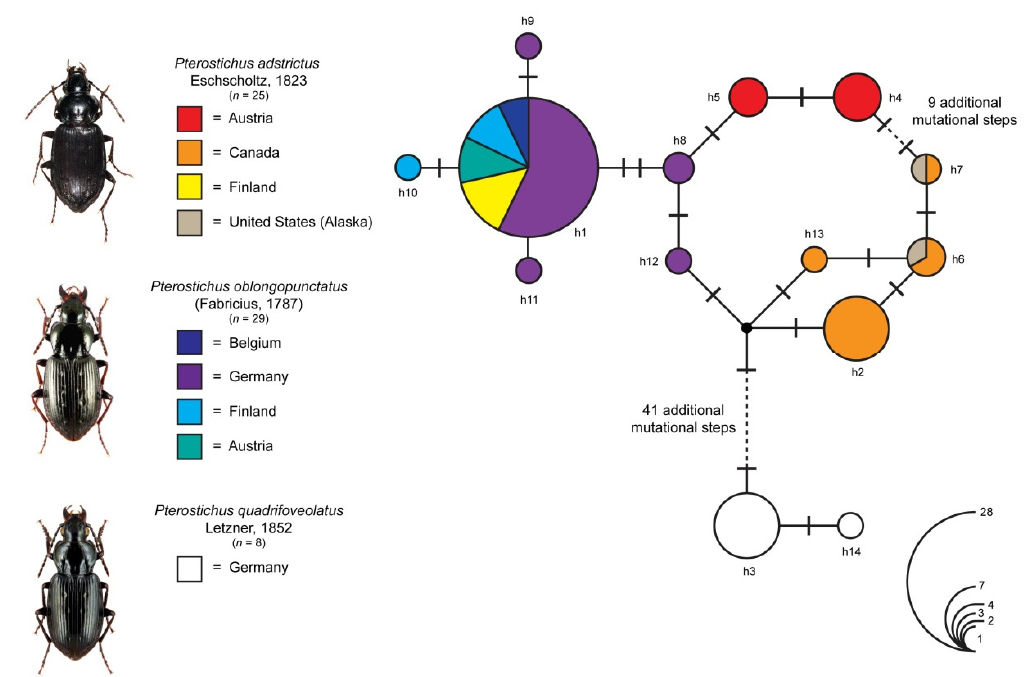
Figure 5. Maximum statistical parsimony network of Pterostichus adstrictus , P. quadrifoveolatus and P. oblongopunctatus . Default settings for connection steps were applied and gaps were treated a fifth state. Bars represent single mutational changes whereas small black dots indicate missing haplotypes. The numbers of analyzed specimens ( n ) are listed and the diameter of the circles is proportional to the number of specimens per haplotype (see open circles with numbers). Beetle images were obtained from www.eurocarabidae.de, except for P. adstrictus (photographer: Ditta Balke).